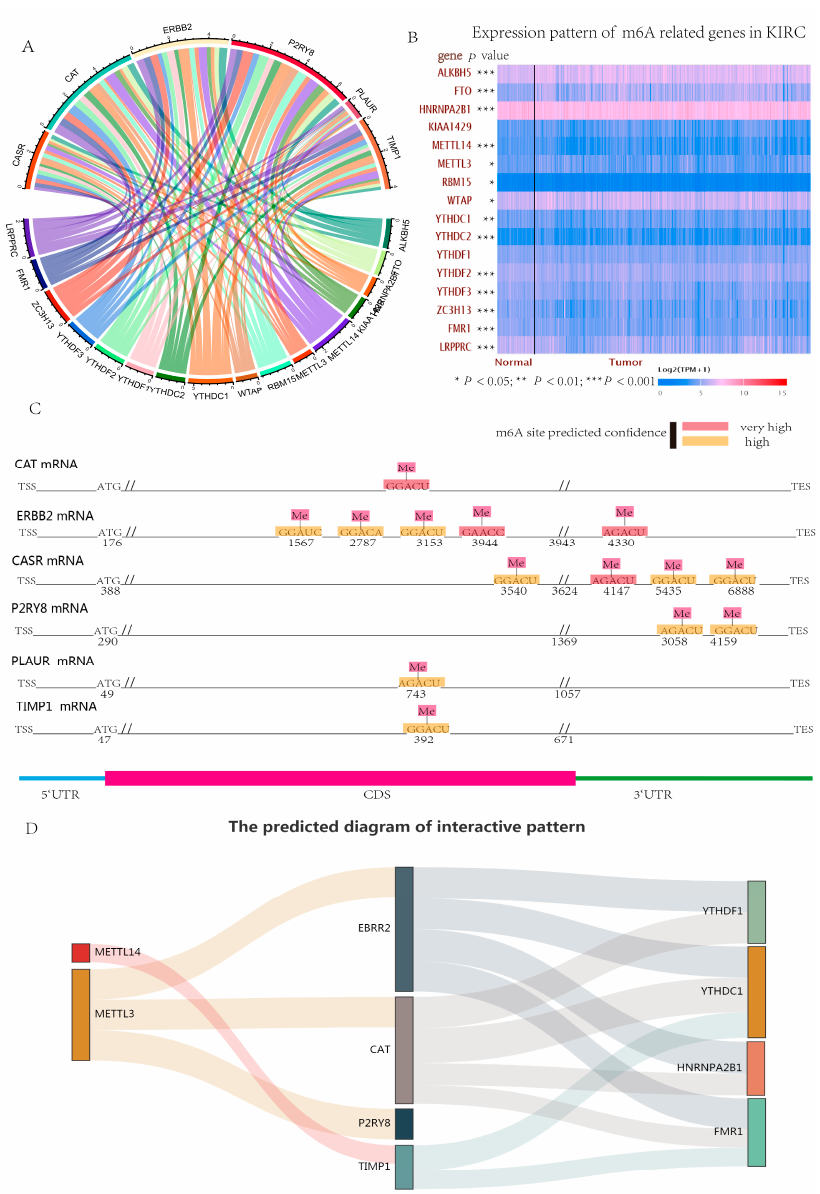
Figure 11. The expression of m6A-related genes, the predicted m6A sites of hub genes, and the predicted diagram of the interactive pattern. ( A ) Circos diagram visualizing the correlation strength between hub genes and m6A-related genes. The larger the gene’s region, the greater the correlation. There was a close correlation between the expression of P2RY8, ERBB2, CAT, TIMP1, and m6A-related genes. ( B ) The heatmap shows the expression of m6A-related genes between tumor and normal tissues. Among the 16 m6A-related genes, they all had differential expression, except KIAA1429 and YTHDF1. * means p < 0.05, ** means p < 0.01, *** means p < 0.001. ( C ) The distribution of the predicted m6A sites using the SRAMP web server based on the sequence data from Nucleotide-NCBI. Red indicates that the confidence of the predicted m6A sites is very high, and yellow indicates that the confidence is high. The numbers below the line depict the position of m6A sites. “//” represent “Start codon” and “Stop codon”. ( D ) The predicted diagram of the interactive pattern. The interactive diagram was made using data from the ENCORI and catPARID databases. First, we queried the interactive possibility of writers/erasers/readers with hub genes in ENCORI. Then, the interactive score was confirmed and obtained in the catPARID database. The thickness of the line represents the interactive